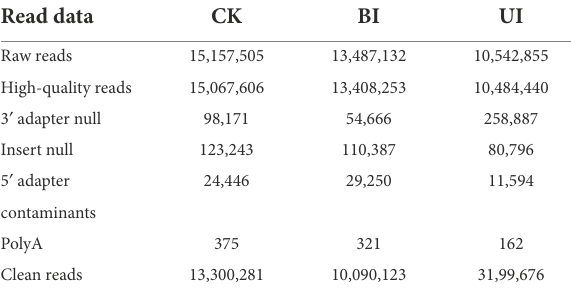
TABLE 1 Statistics of small RNA libraries analyzed by high-throughput